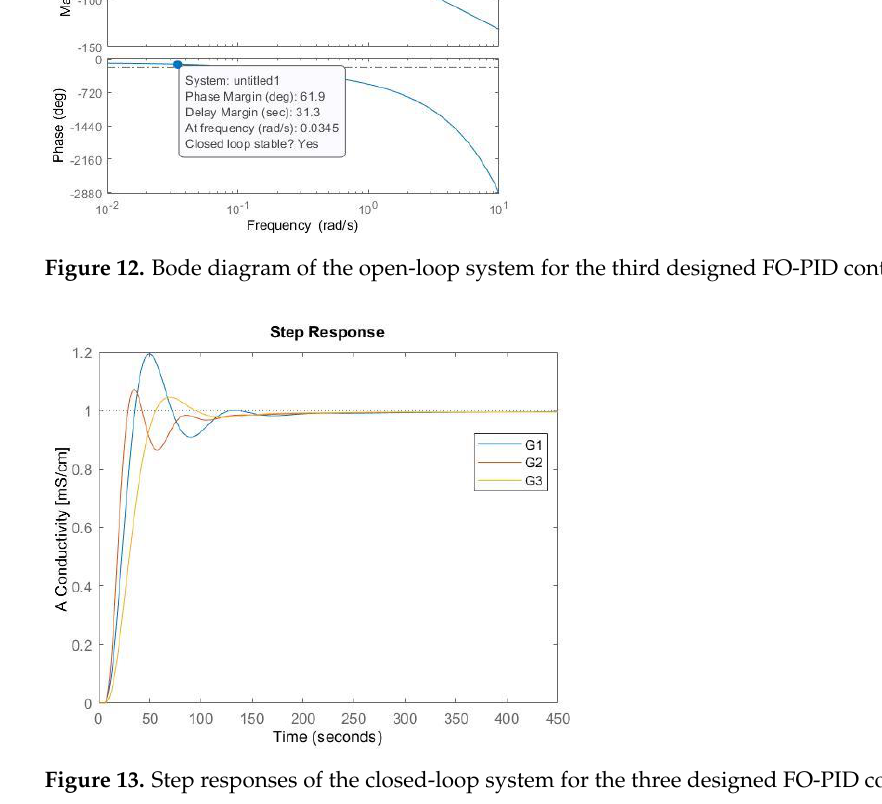
Figure 13. Step responses of the closed-loop system for the three designed FO-PID controllers.